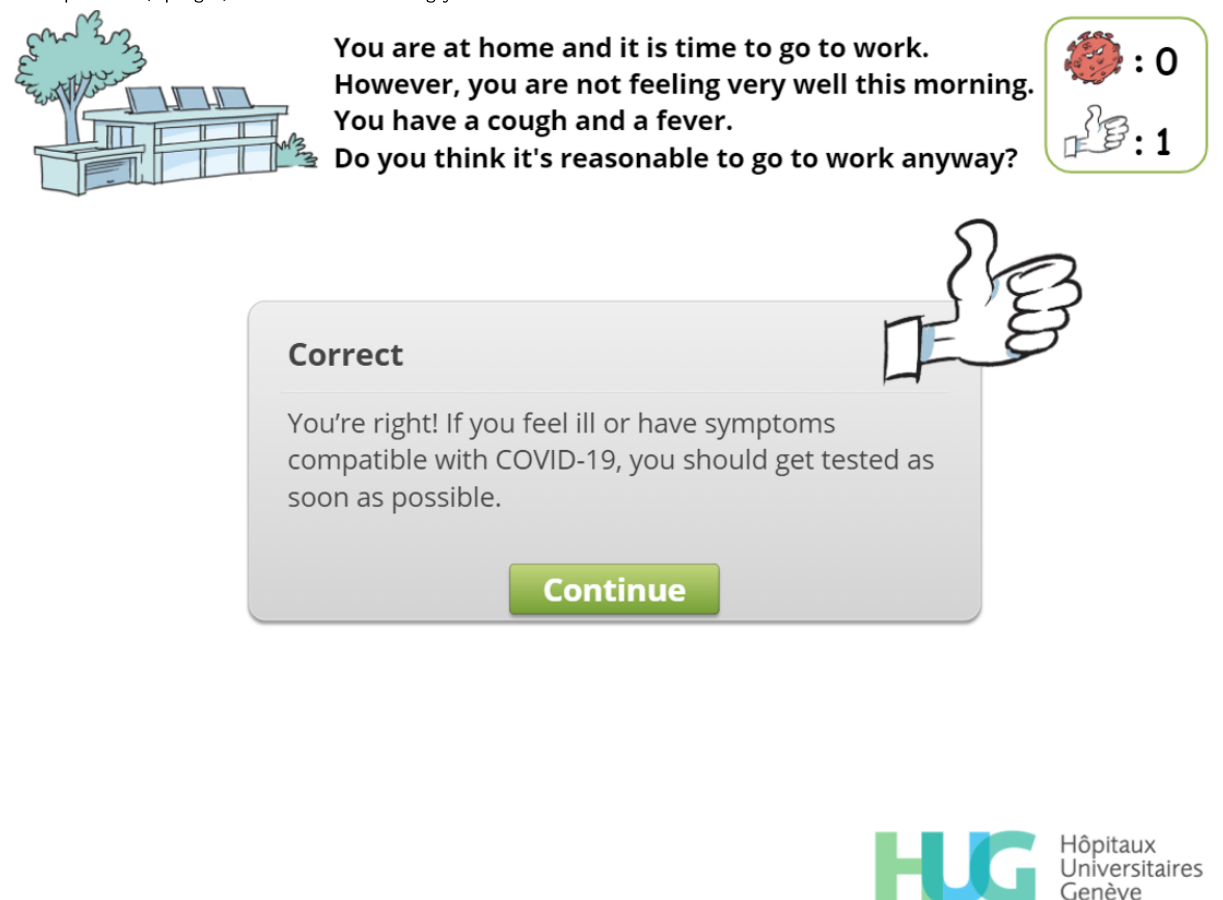
Figure 9. Feedback. The player has chosen not to go to work, and this choice is encouraged by a positive message and by a "thumbs-up" image. The "thumbs-up" count (top right) has increased accordingly.